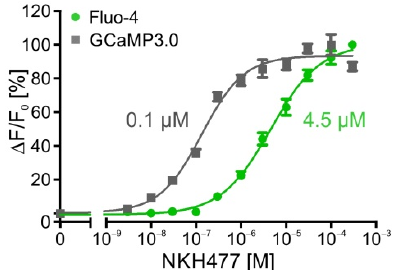
Figure 2. Stimulation of DmOct β 1-expressing cells with NKH477. Human embryonic kidney cells (HEK293) constitutively expressing DmOct β 1 receptors and CNGA2 channels (flpTM-DmOct β 1) were either loaded with Fluo-4 (green) or stably transfected with GCaMP3.0 (grey). Concentration-dependent effects of NKH477-mediated activation of cell endogenous adenylyl cyclases on [Ca 2+ ] i were determined. Relative change in fluorescence ( Δ F/F 0 ) is given as the percentage of the value obtained with the highest NKH477 concentration (=100%). Application of NKH477 led to concentration-dependent increases in the fluorescence signal originating from adenylyl cyclase activation and subsequent opening of CNGA2 channels causing Ca 2+ influx into the cell. During measurements, cAMP degradation was inhibited with 100 µM IBMX. A total of five independent measurements were performed. Data points represent the mean ± SD of a representative eight-fold determination. Table 1. EC 50 values of DmOct α 1B and FlpTM-DmOct β 1 cell lines for octopamine and NKH477. EC 50 values of DmOct α 1B and FlpTM-DmOct β 1 cell lines for octopamine and NKH477 were de- termined with Fluo-4 and GCaMP3.0. Measurements with flpTM-DmOct β 1 cell lines were per-